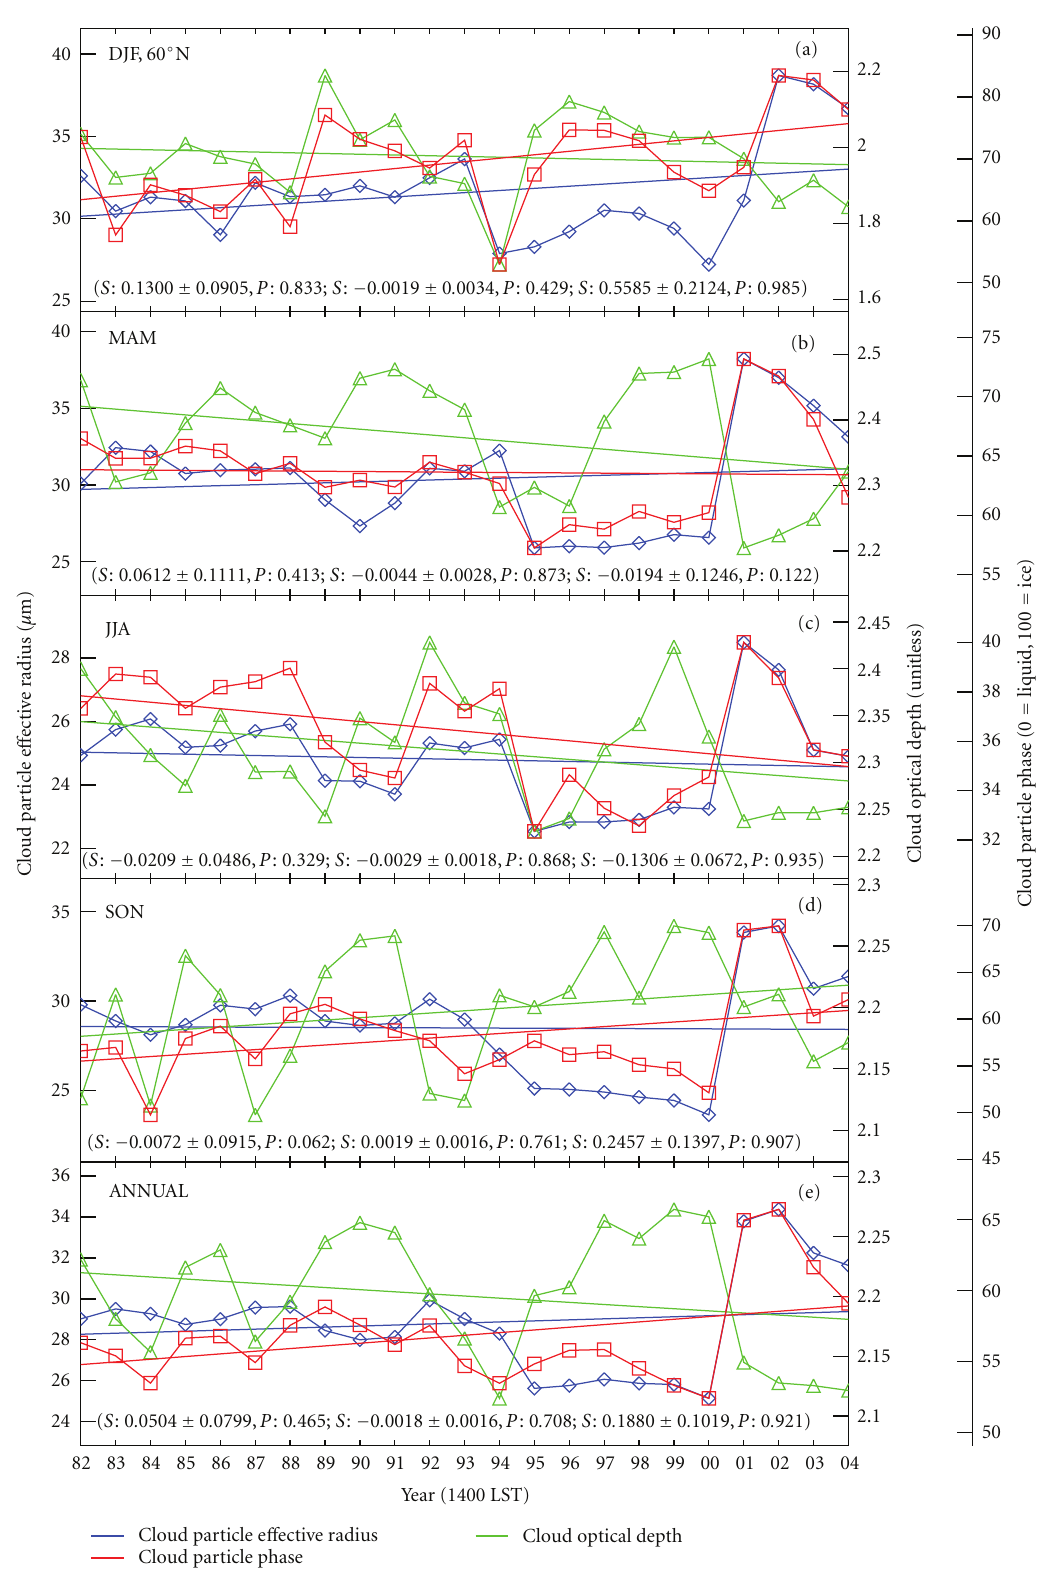
Figure 8: As in Figure 3, but for cloud particle phase, e ff ective radius and optical depth. The first pair of S and P denotes the cloud particle e ff ective radius trend (blue), the second pair is for the cloud optical depth trend (green), and the third pair represents the cloud particle phase trend